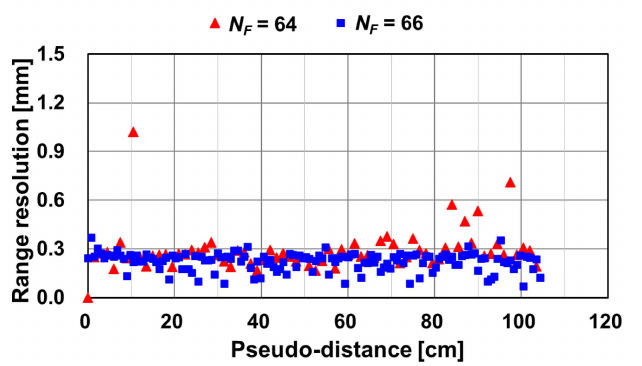
Figure 17. Measurement results of the depth resolution for N F = 64 and N F =